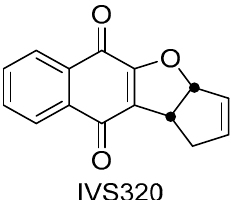
Figure 1. Chemical structure of IVS320 (3 a ,10 b -dihydro-1 H -cyclopenta[ b ]naphtho[2,3- d ]furan-5,10-dione).